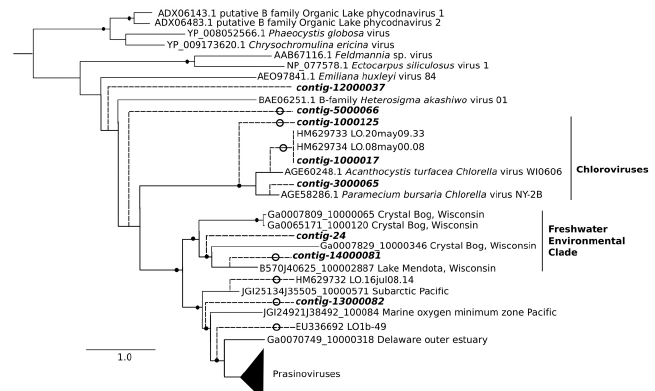
Figure 5. Evolutionary Placement Algorithm (EPA) of the viral DNA Pol contigs which contributed most to the dissimilarity between freshwater and brackish/saltwater samples in the Similarity Percentage (SIMPER) analysis. Closed circles show nodes of reference tree with bootstrap values >50 (out of 100). Open circles show contigs placed by EPA with Likelihood Weight >0.5. Scale bar shows number of substitutions. Branch lengths to contigs (broken lines) are arbitrary. Out-group (not shown) is Aeromonas virus Aeh1. The prasinovirus clade, collapsed here for clarity, is shown in full in Figure 6.